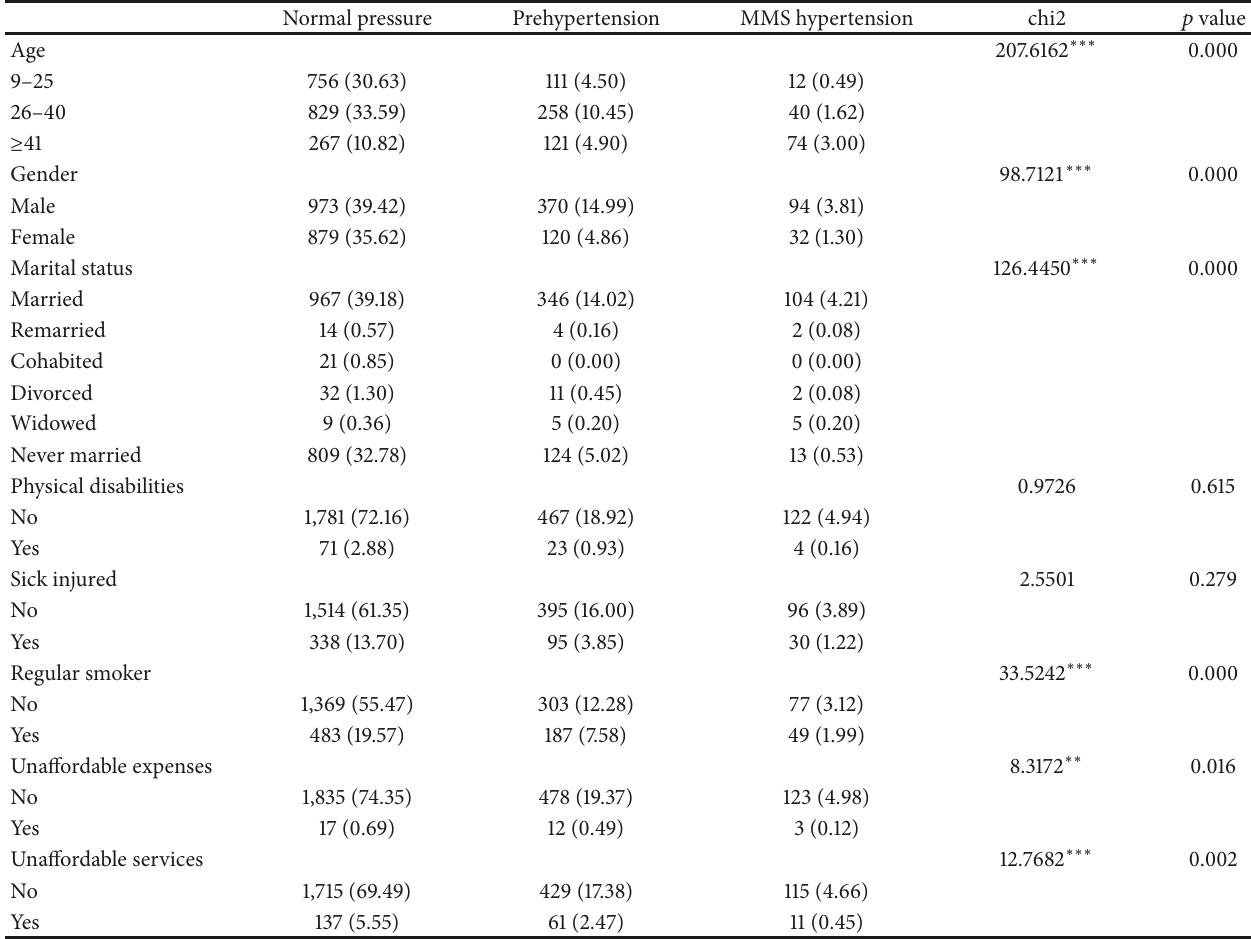
Table 1: Demographic characteristics among adults with hypertensive state, 𝑁